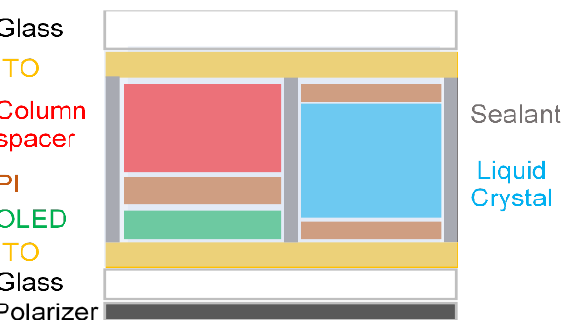
Figure 9. Experimental cell preparation for the proposed transparent display and this structure will apply only to the polarized mode.